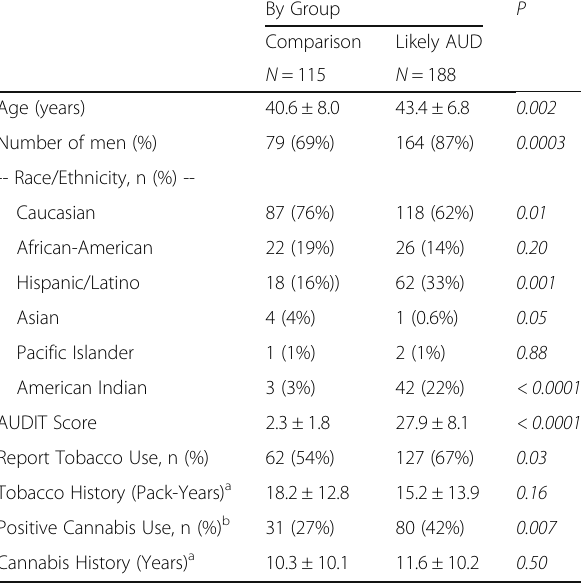
Table 1 Description of the Study